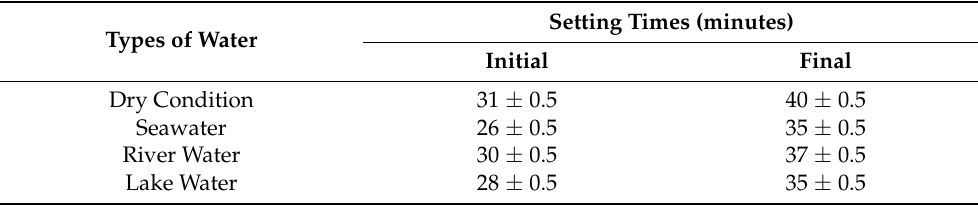
Table 2. Setting time of AAFA cast